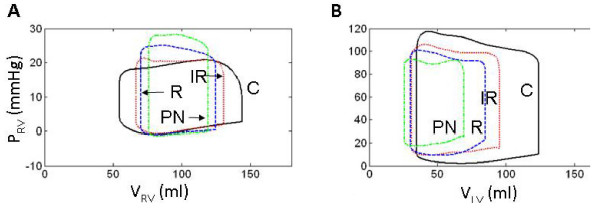
Comparison of Model Ventricular Pressure-Volume Loops. Comparing modeled ventricular function curves of normal physiology (C, solid black line) with LVDD due to impaired LV wall relaxation (IR, dotted red line), increased LV wall stiffness (R, dashed blue line), and combined impaired relaxation and increased wall stiffness (PN, dash-dot magenta line). Panels A and B show RV and LV chamber pressures and volumes, respectively. All simulations here are with normal systolic contractility. LVDD types: IR (impaired relaxation); R (resistive) and PN (pseudo-normal) patterns (discussed later).